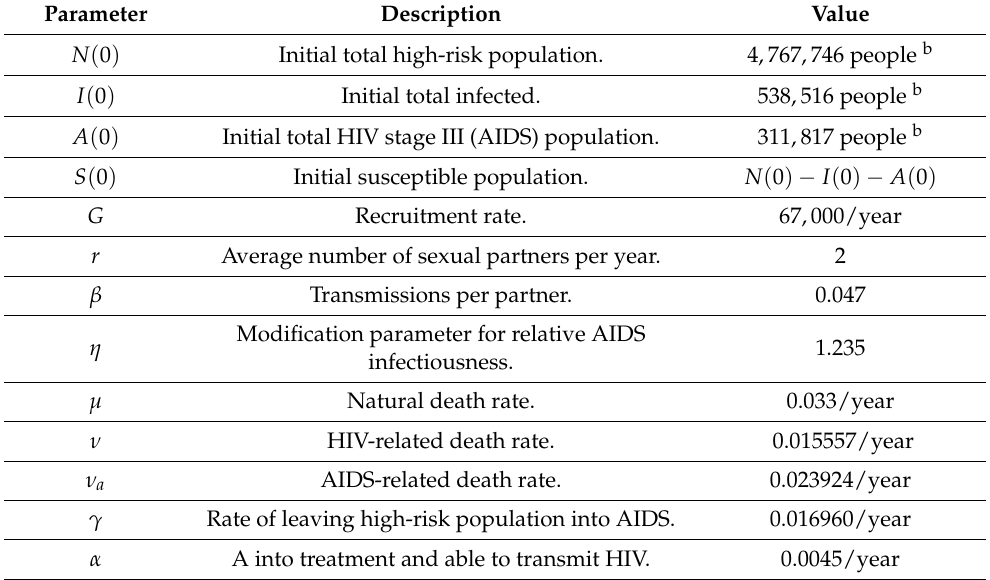
Table 2. List of SIA model parameters a .